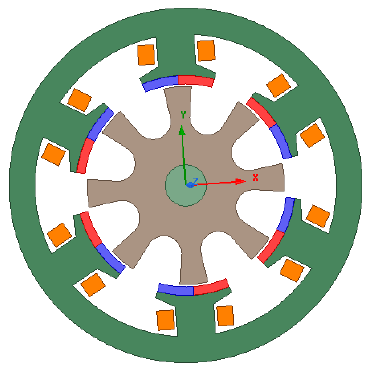
Figure 5. 3-phase, eight/six-pole flux-reversal machine (FRM) [16,17].